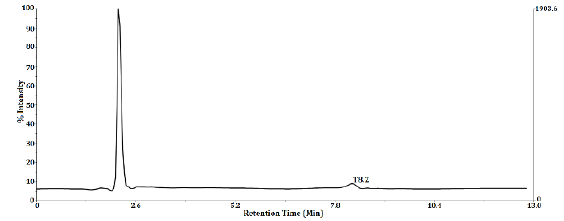
Figure 4. Liquid Chromatography profile of AEW-1.